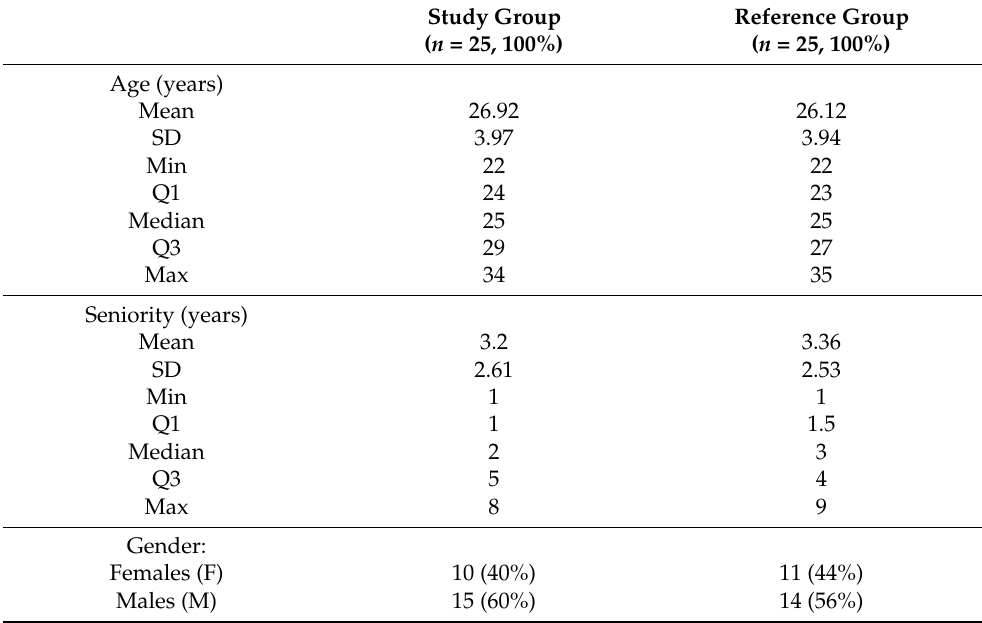
Table 1. Clinical summary of the subjects.